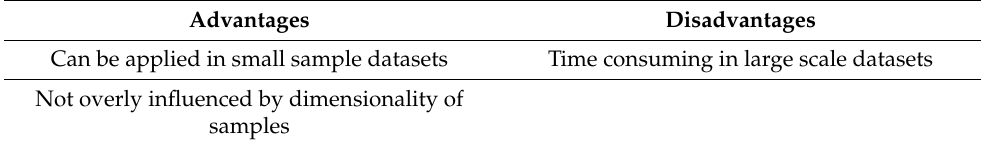
Table 3. The advantages and disadvantages of SVM.